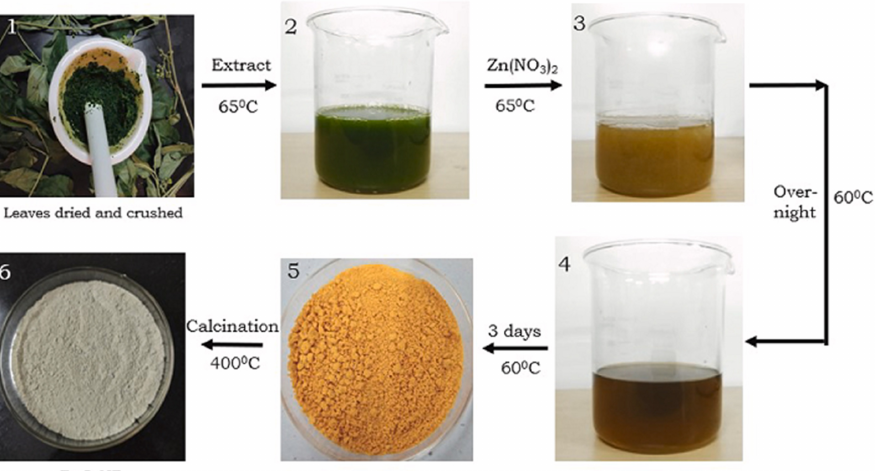
Figure 12. A schematic illustration of the plant extraction method. Reproduced with permission from [59].